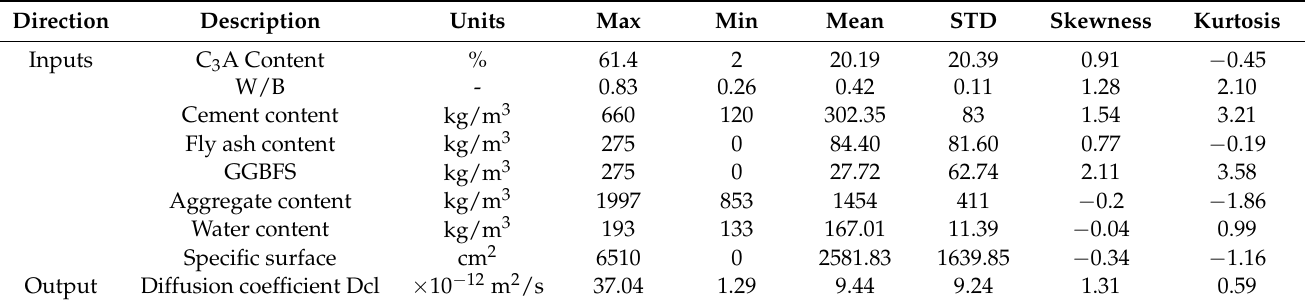
Table 1. Initial statistics of the dataset.